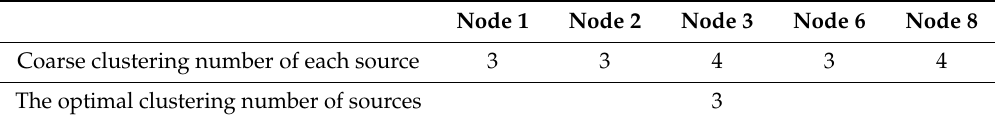
Table 2. Coarse Clustering Number of Renewable Sources. Table 3. Coarse Clustering Number of Loads.